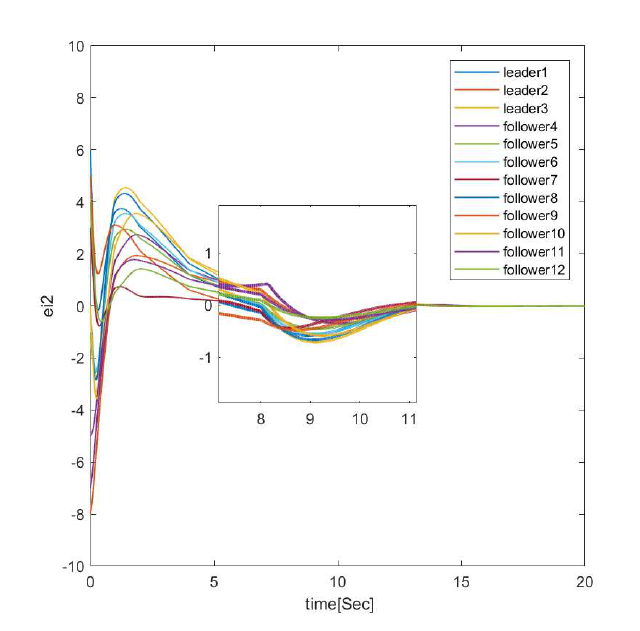
Figure 7. Position State Component 2 of Agent with hierarchical